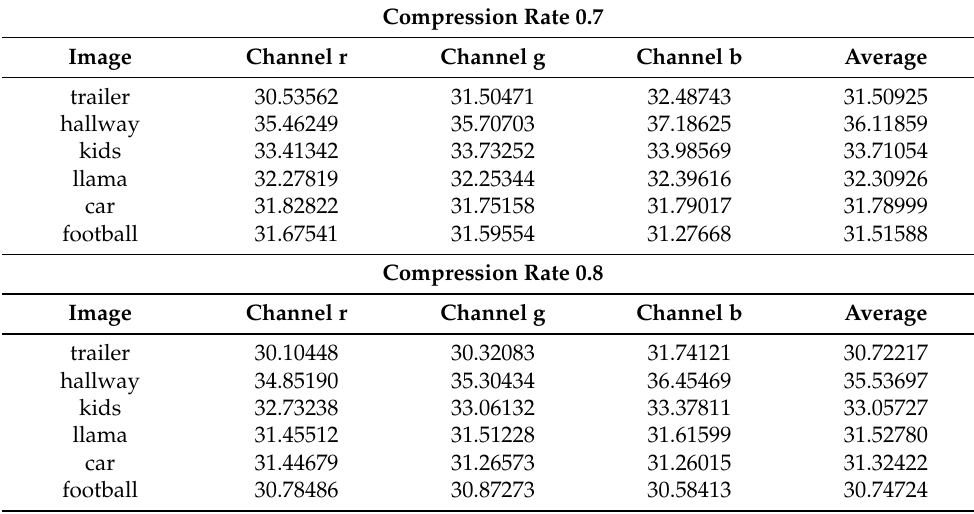
Table 1. PSNR values under compression rates 0.7 and 0.8 (Unit: